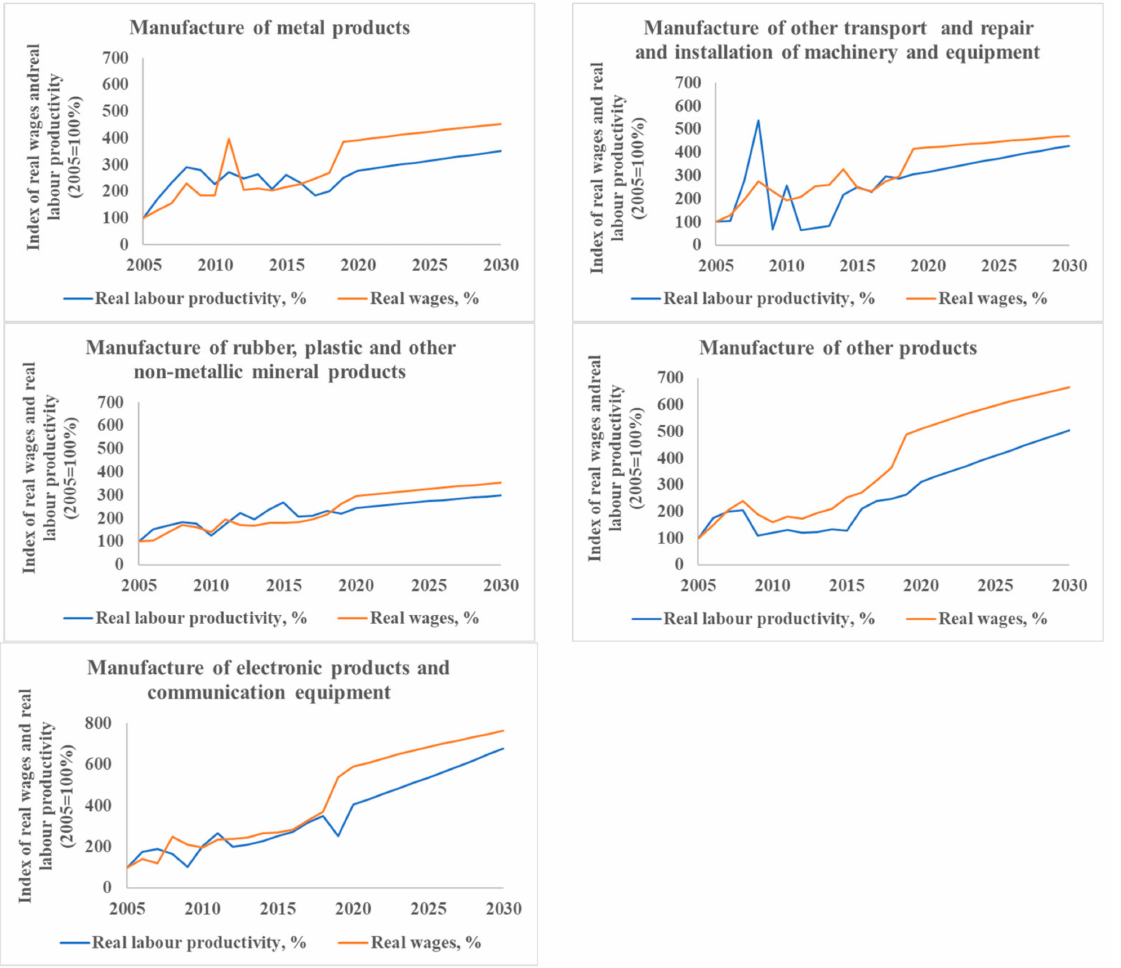
Figure 18. Index of real wages (and salaries) and real labour productivity during 2005–2020 (own